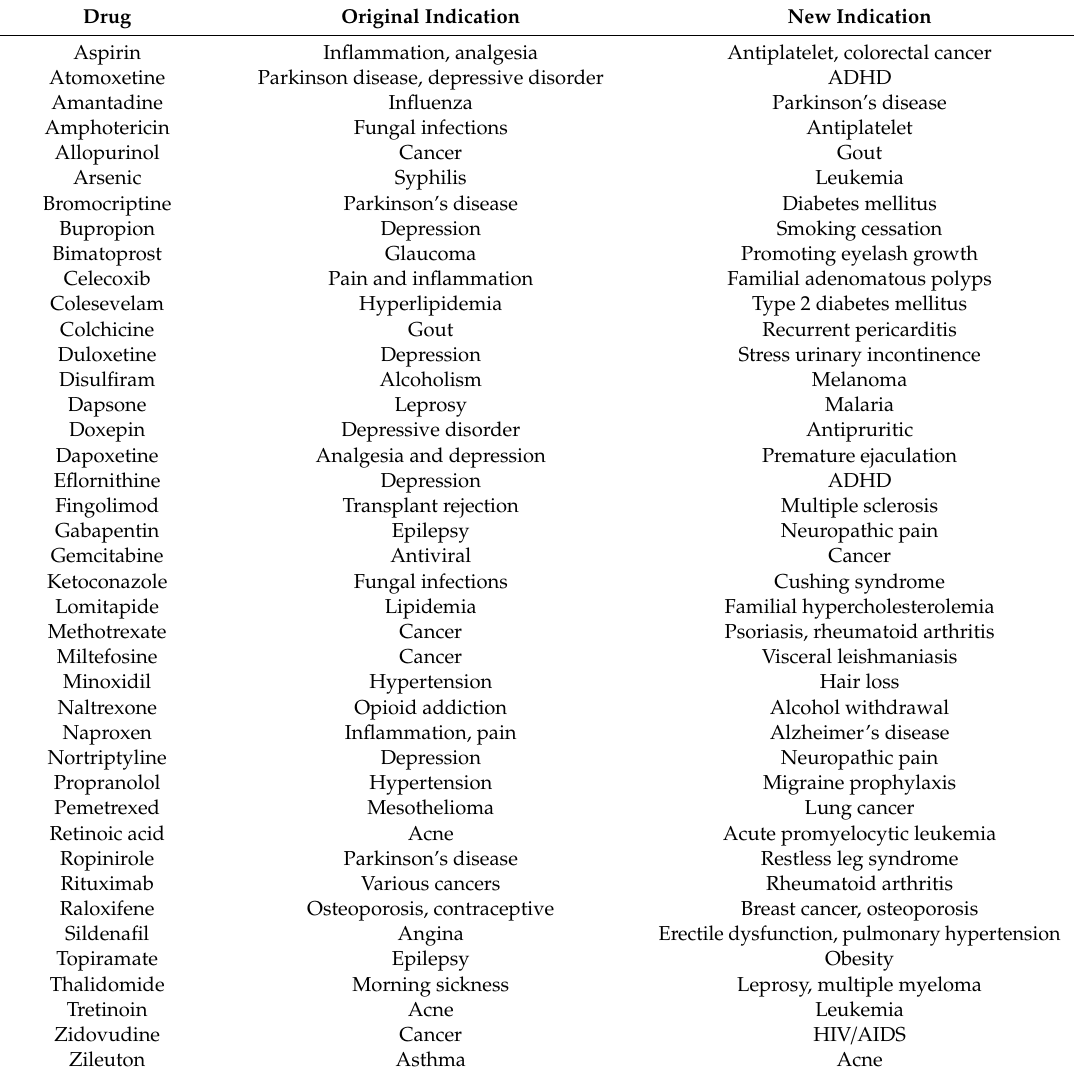
Table 1. Repositioned drug